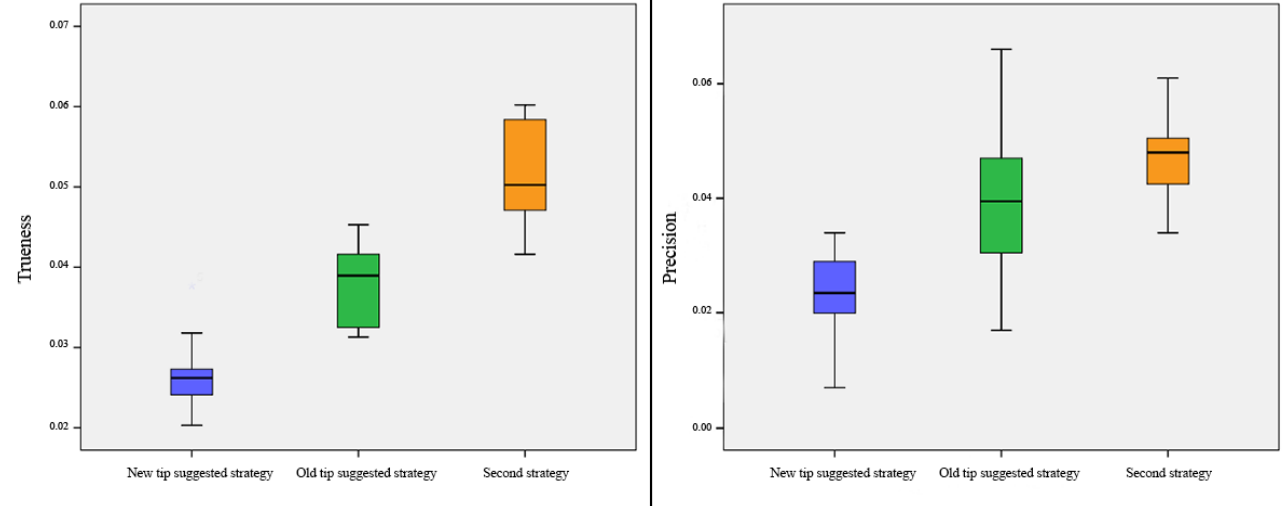
Table 2. Mean difference in trueness and precision between two different programs of superimposition (Geomagic Control X and Medit Compare).